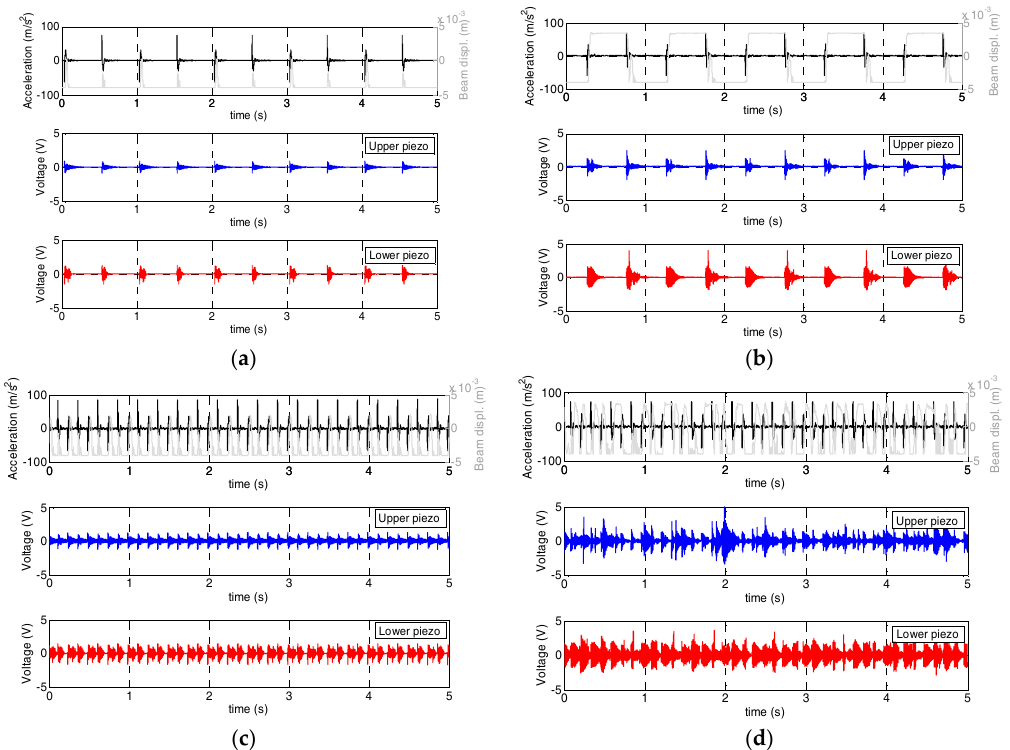
Figure 3. Examples of the measured acceleration, displacement of the beam and output voltage from the two piezoelectric transducers, without ( a , c ) and with ( b , d ) the repulsive permanent magnet, in case of ( a , b ) Acc max = 71.1 m/s 2 at 1 Hz, ( c , d ) Acc max = 80.4 m/s 2 at 4 Hz,